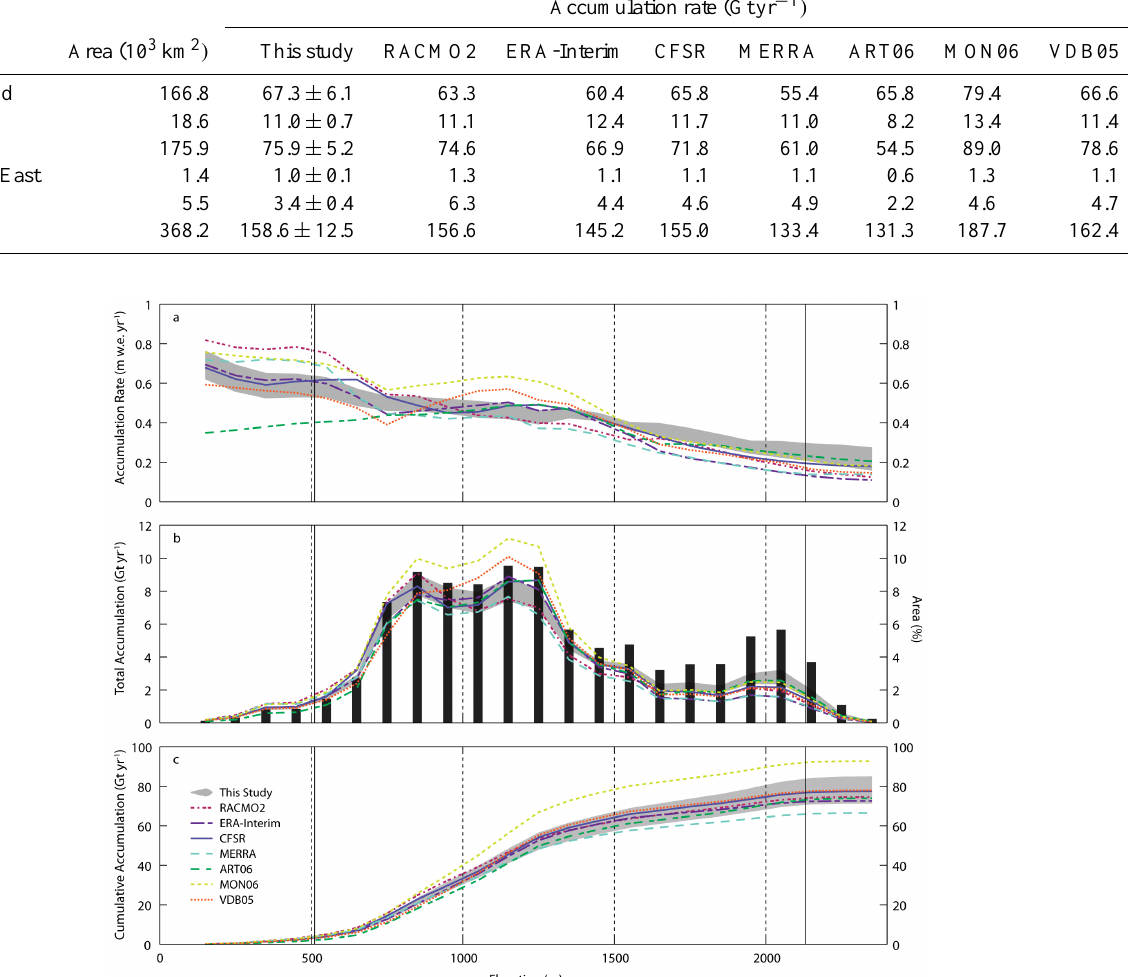
Figure 8. The elevation-dependent accumulation distribution for Pine Island glacier (including the Wedge) and comparison with climatolo- gies and reanalysis and climate models. For each part, the grey shaded area shows the quantity of interest from our final accumulation grid including its ± 1 σ deviation. The climatologies and reanalysis and climate models do not have errors because the products do not provide error grids. The three part figure shows (a) the average accumulation rates over 100m elevation bins, (b) the bin-summed accumulation rates scaled by the cell size of 9km 2 with bars representing the bin size, and (c) the cumulative bin-summed accumulation rates from (b) . The solid vertical black lines on each plot display the elevation limits of our radar-derived accumulation measurements, and thus bound the area with high data